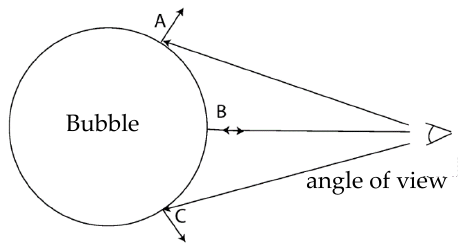
Figure 6. Calculation Schematic.